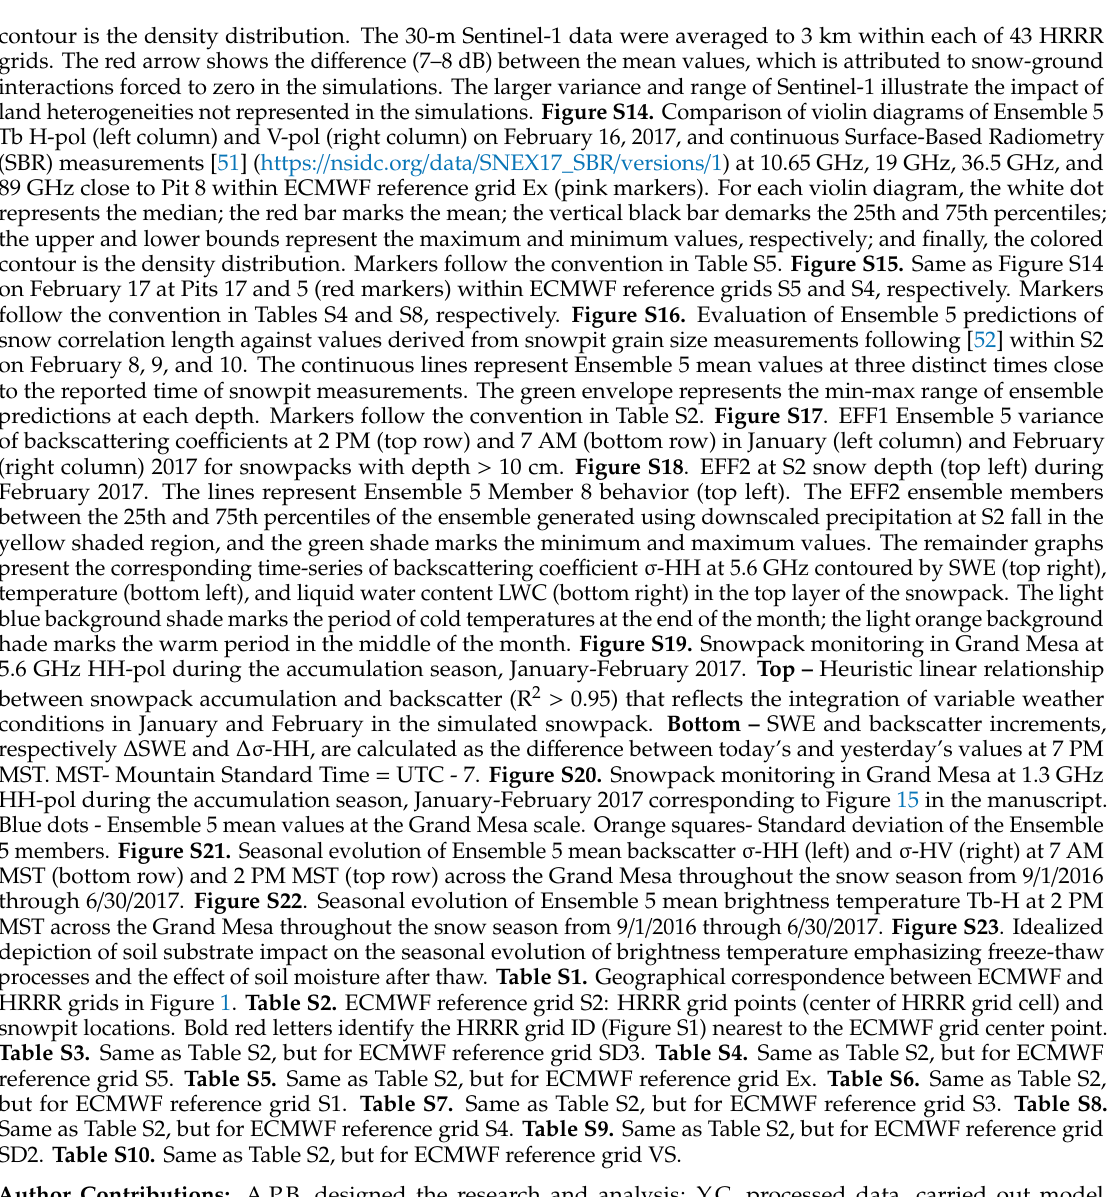
snowpit locations. Bold red letters identify the HRRR grid ID (Figure S1) nearest to the ECMWF grid center point. Table S3. Same as Table S2, but for ECMWF reference grid SD3. Table S4. Same as Table S2, but for ECMWF reference grid S5. Table S5. Same as Table S2, but for ECMWF reference grid Ex. Table S6. Same as Table S2, but for ECMWF reference grid S1. Table S7. Same as Table S2, but for ECMWF reference grid S3. Table S8. Same as Table S2, but for ECMWF reference grid S4. Table S9. Same as Table S2, but for ECMWF reference grid SD2. Table S10. Same as Table S2, but for ECMWF reference grid